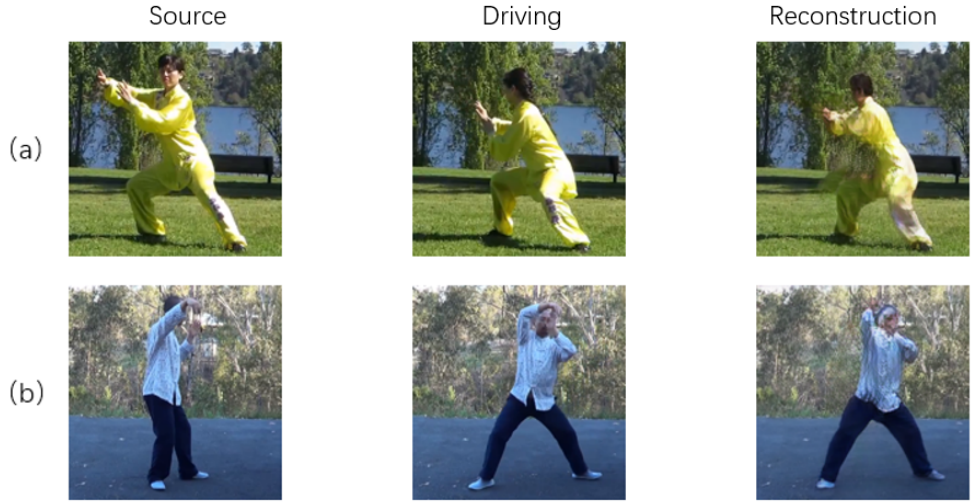
Figure 14. The reconstruction failure case of our method. ( a ) An error caused by the character’s clothing color was very similar to the background color. ( b ) An error caused by the source frame was lacking some